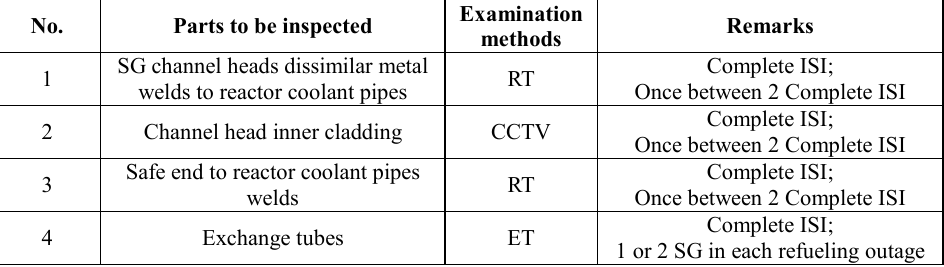
Table 2. Different ISI items of the primary side of the